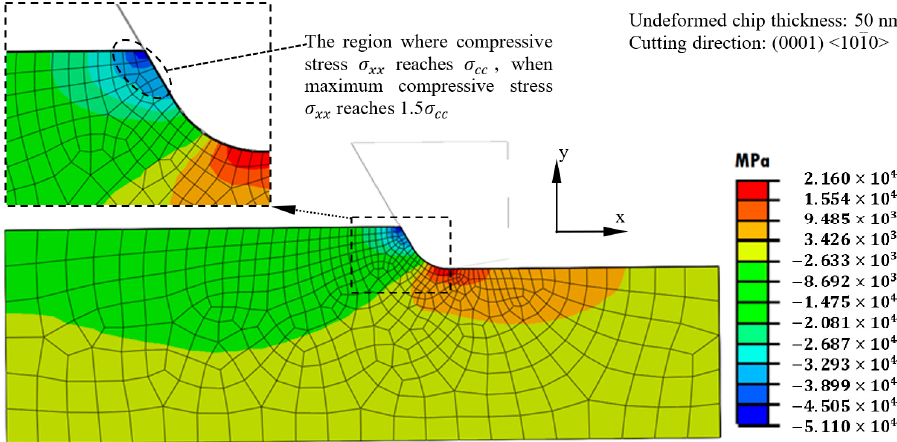
Figure 7. Distribution of (cid:2026) (cid:3051)(cid:3051) in the cutting zone by FEM modelling.